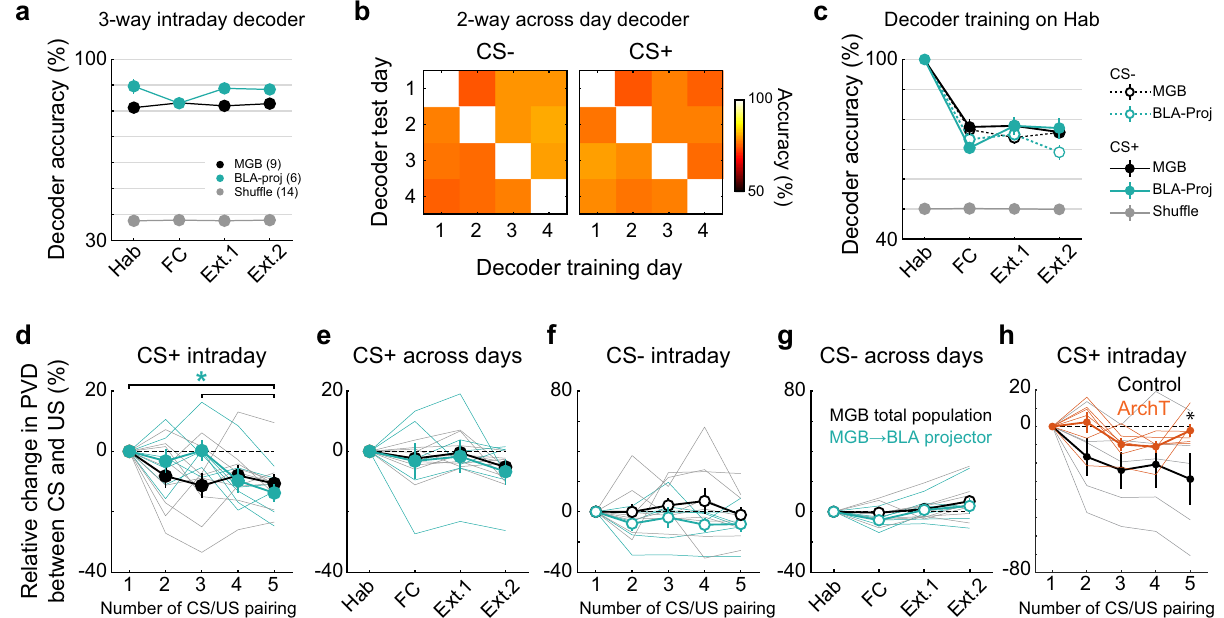
Fig. 6 MGB population dynamics are stable across days. a Intraday three-way decoder of CS + , CS − and baseline population responses in CaMKII- positive (black) and identi fi ed amygdala-projecting MGB neurons (turquoise) reached a minimum mean accuracy of 81% across animals. Decoder accuracy dropped to chance levels for decoders trained on randomly label training sets (data presented as mean values± s.e.m.). b Intra- and across day accuracy of decoders trained on CS + or CS − vs. baseline responses, respectively. 1: Hab, 2: FC, 3: Ext. 1, 4: Ext. 2. c Quanti fi cation of intra and across day decoder accuracy for decoders trained on habituation day data. Mean decoder accuracy across days is >70% for CS + and CS − population responses in CaMKII-positive and identi fi ed amygdala-projecting MGB neurons (MGB → BLA N = 6 mice, MGB N = 9 mice, data represent mean ± s.e.m.). Relative change in Euclidean population vector distance between the CS + ( d , e ) or CS − ( f , g ) and the US within the fear conditioning session ( d , f ) or across the individual days of the behavioural paradigm ( e , g ). Statistics: d: Friedman test across the relative change in CS + to US PVD of MGB → BLA-projectors ( p < 0.01), Dunn-Sidak multiple comparisons test 1 st and 3 rd vs. 5 th CS/US pairing, p < 0.05. G: Friedman test across the relative change in CS − to US PVD of the total BLA-population ( p < 0.05), Dunn-Sidak multiple comparisons test FC vs. Ext.2: p < 0.05. All other data sets in d-g: p > 0.05. MGB population: N = 9 mice, MGB → BLA-projectors: N = 6 mice (data represent mean ± s.e.m.). h Relative change in PVD between the CS and US for Control and ArchT (2-way ANOVA followed by Sidak ’ s post hoc test, p < 0.005, 5 th CS + presentation Control vs. ArchT, p = 0.0438, Control N = 5 mice, ArchT N = 6 mice, data represent mean ± MGB neurons during associative learning (Friedman test, p <